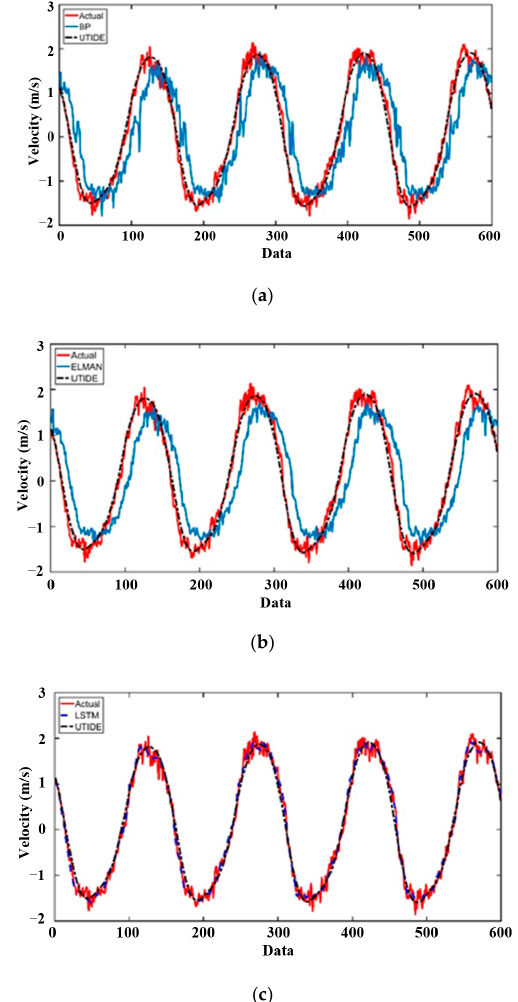
Figure 11. Comparison results of the proposed method by using three machine learning algorithms and UTide (20 m under sea surface). ( a ) Comparison of the BP method, UTide method, and actual value, ( b ) Comparison of the ELMAN method, UTide method, and actual value, ( c ) Comparison of LSTM method, UTide method and actual value.